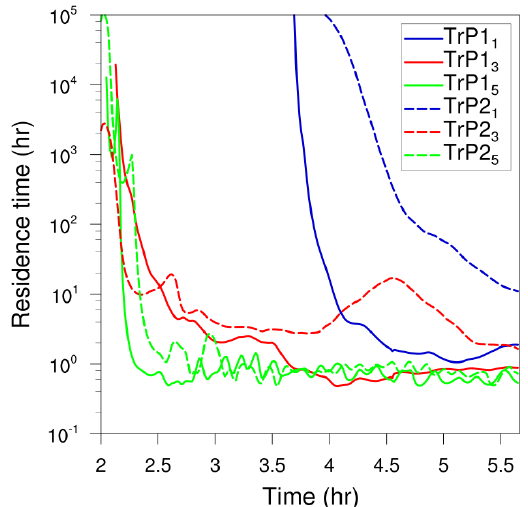
Figure 11. Time series of the residence time ( T ) of tracers TrPn 1 (blue lines, tracer released at U ), TrPn 3 (red lines, tracer released at J ) and TrPn 5 (green lines, tracer released at D ). Note that n = 1 for P1 and n = 2 for P2. Solid lines represent values of P1, while dashed lines stand for P2. The location of the source of each of the tracers is presented in Figure 1a. The control volume used to calculate the residence time is the volume of the valley segment for each of the tracer emission sites up to the height of the